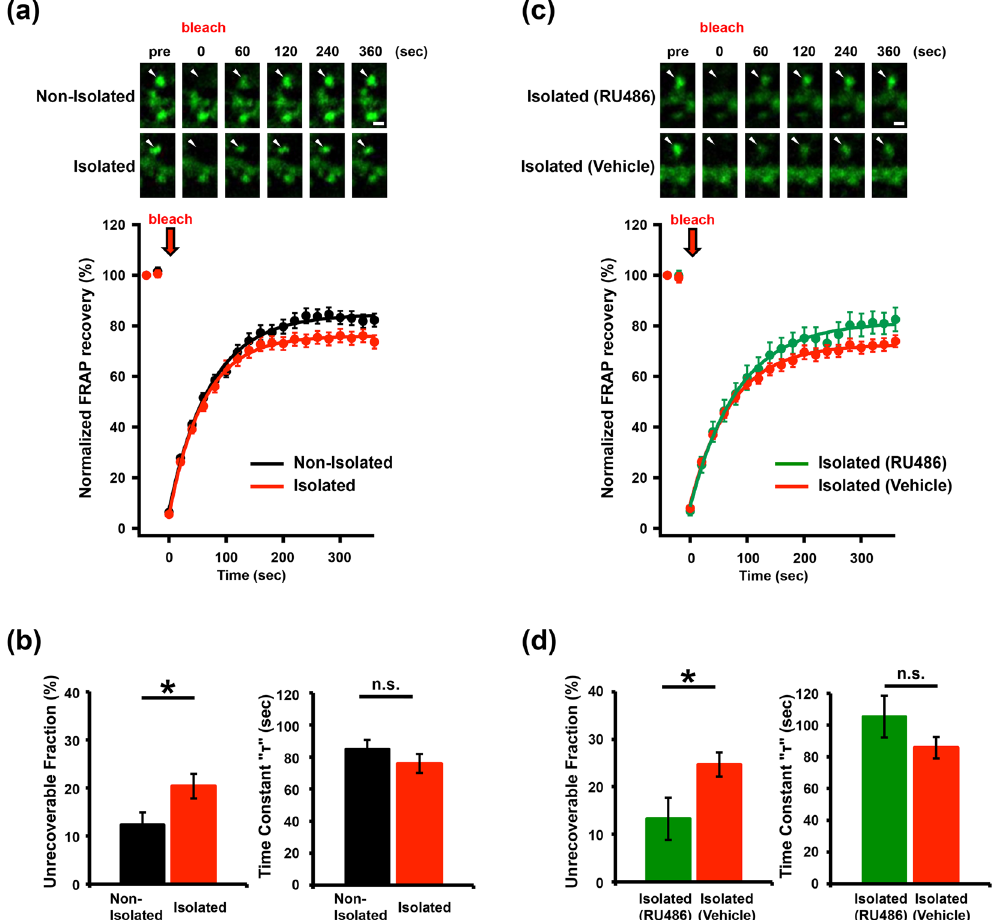
Figure 1. Social isolation alters actin dynamics via glucocorticoid signalling. ( a ) FRAP analysis of GFP-actin in spines from the barrel cortex of isolated or non-isolated rats. Representative images and graphs depicting the recovery of GFP-actin signals before and after spine photobleaching are shown. ( b ) Recovery time constant and quantification of the unrecoverable fraction of spines from isolated or non-isolated rats. The unrecoverable actin fraction in the spines of the barrel cortex was increased in isolated rats (n = 54) compared to non-isolated controls (n = 57). ( c,d ) The isolation-induced increase in the unrecoverable fraction was blocked by the administration of RU486 (n = 22) during isolation, but not by treatment with vehicle (n = 39). Representative images shown in the figures were Gaussian- and unsharp mask-filtered. Arrowheads indicate dendritic spines. Scale bar represents 1 µ m. * P < 0.05 (Unpaired Student’s t-test). Error bars represent